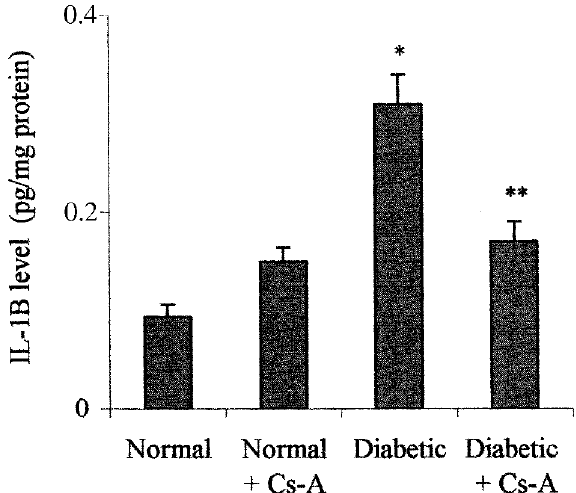
FIG. 1. Level of IL-1 b in retina. The levels of IL-1 b were determined in retinal lysates according to the kit instructions. Data are mean ± SD values from 5 rats from each group. *Significant differences from normal rats. **Significant differences from Cs-A non-treated diabetic rats ( p > 0.05)(one- way ANOVA analysis, Dunnett’s test).